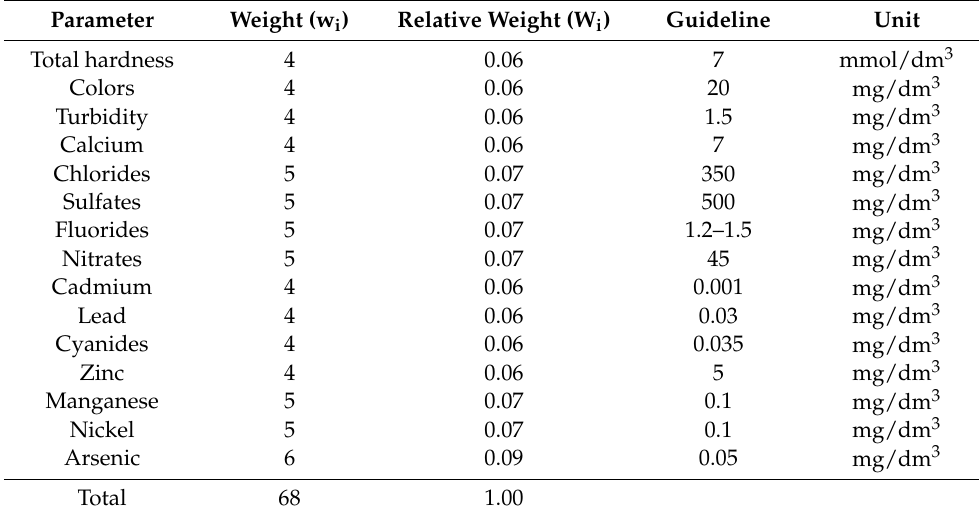
Table 3. Weights and relative weights of the studied parameters.